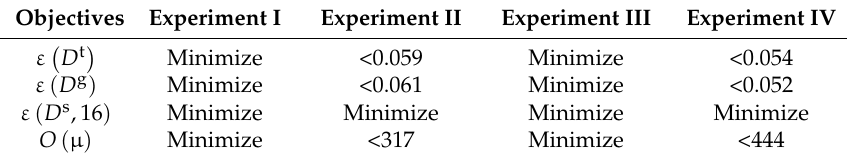
Table 7. Objectives and their corresponding restriction of